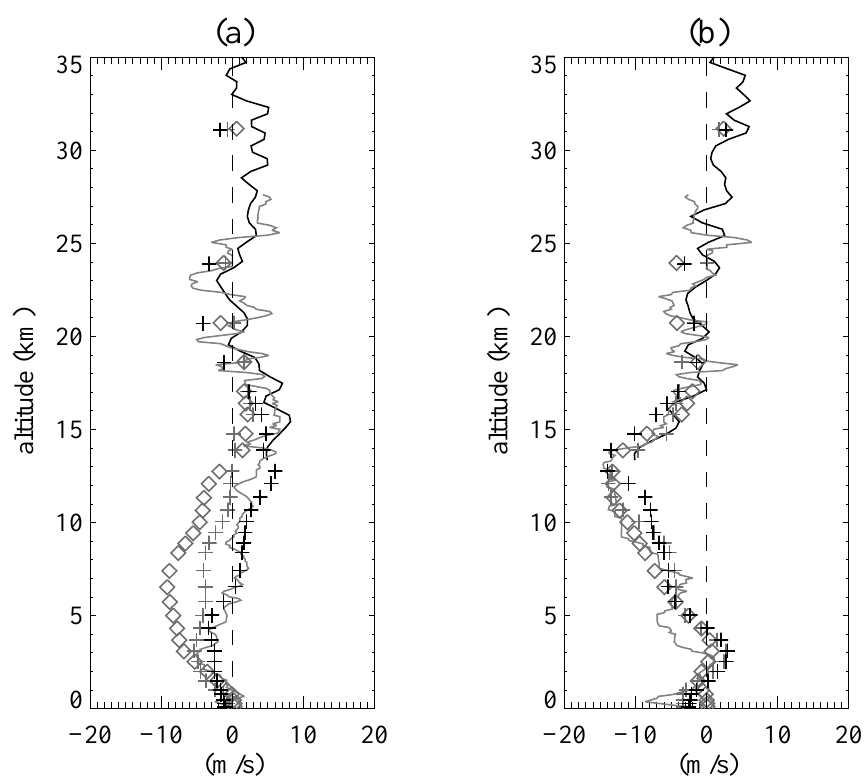
Fig. 1. Zonal ( (a) , positive eastward) and meridional ( (b) , positive northward) wind measured by the Doppler lidar (solid black) on 3 September 1997 (20:00 UTC–04:00 UTC) and by the radiosonde (solid grey) at Nˆımes at 23:00 UTC. Also shown are the ECMWF profiles interpolated at the OHP (18:00 UTC on 3 September 1997 (diamond), and 00:00 UTC (grey crosses) and 06:00 UTC (black crosses) on 4 September 1997).